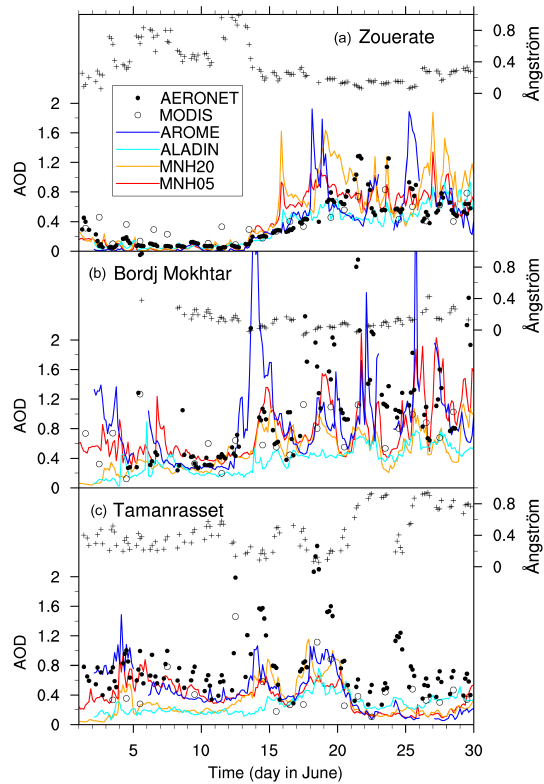
Figure 3. Time evolution of AOD (left vertical axis) from AERONET, MODIS, ALADIN, AROME, MNH20 and MNH05 (see legend box) and of the Ångström exponent (right vertical axis) from AERONET (crosses) at (a) Zouerate, (b) Bordj Mokhtar and (c)